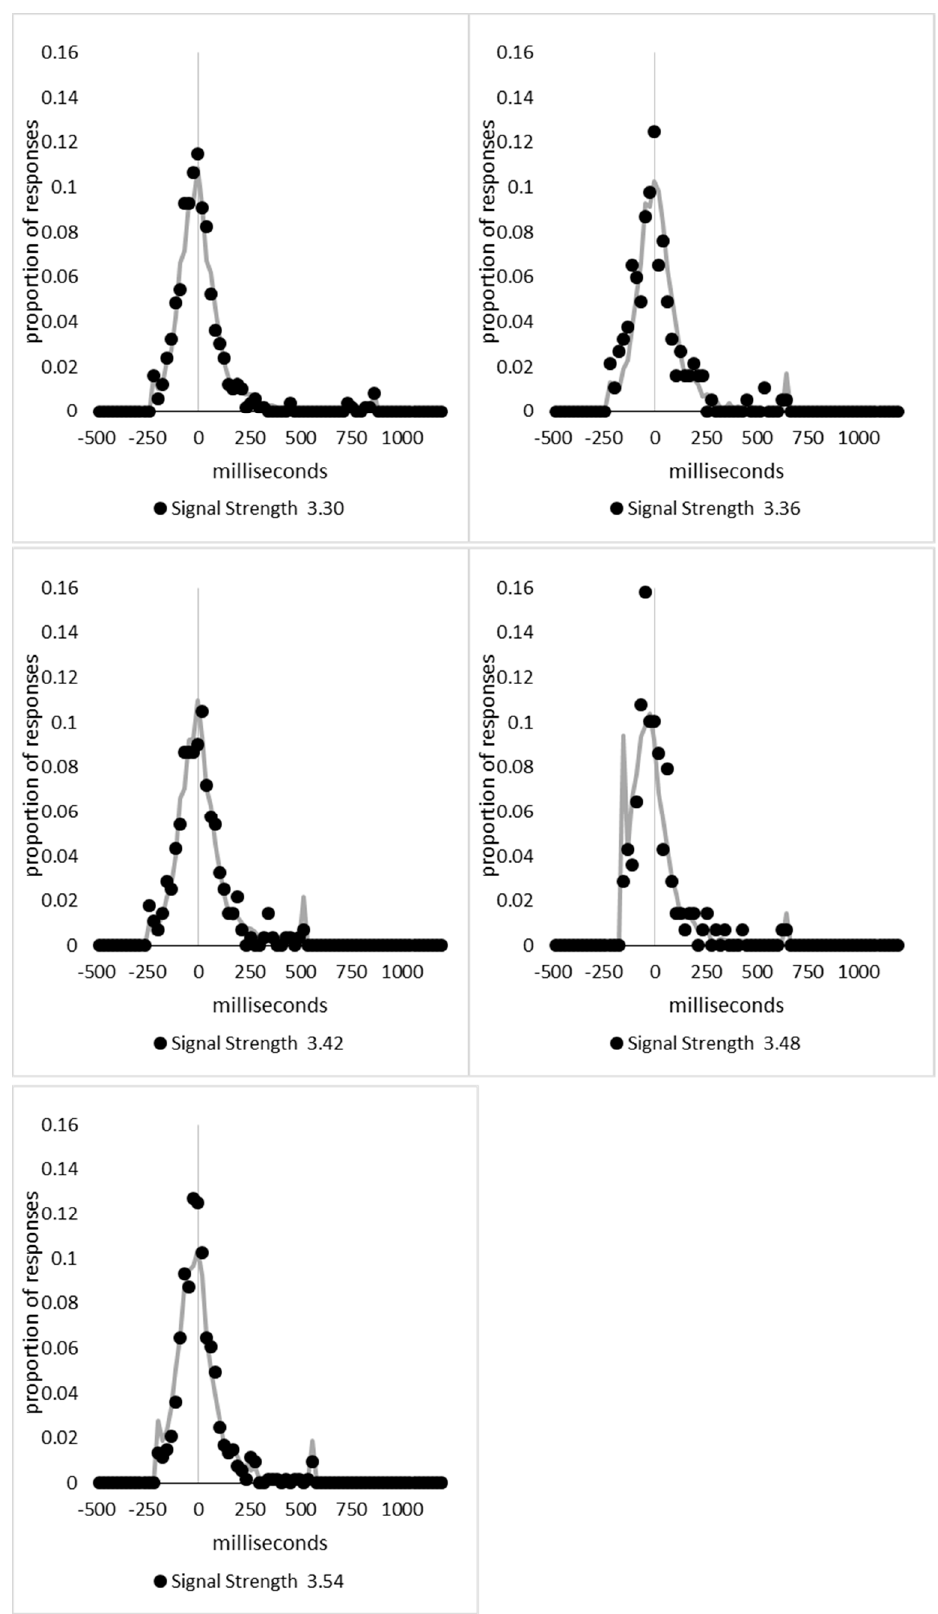
Figure A10. Density functions of the observed data (filled circles) and model (solid line) for signal strength bins 3.30 to 3.54.